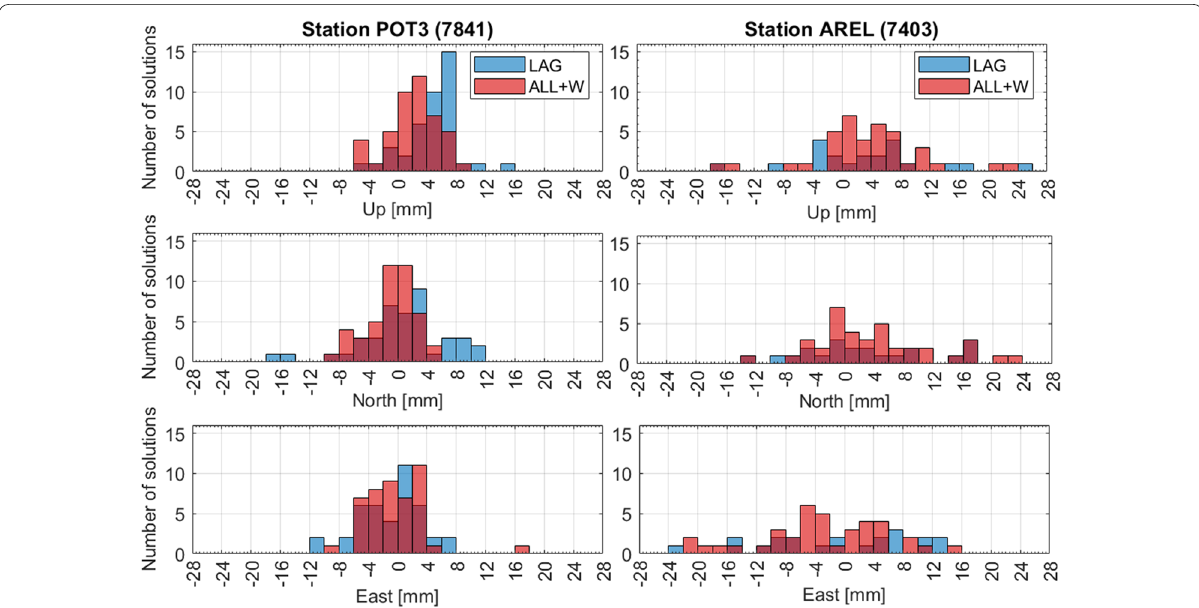
Fig. 12 Histogram of coordinate residuals, w.r.t SLRF2014, in LAG and ALL (right)